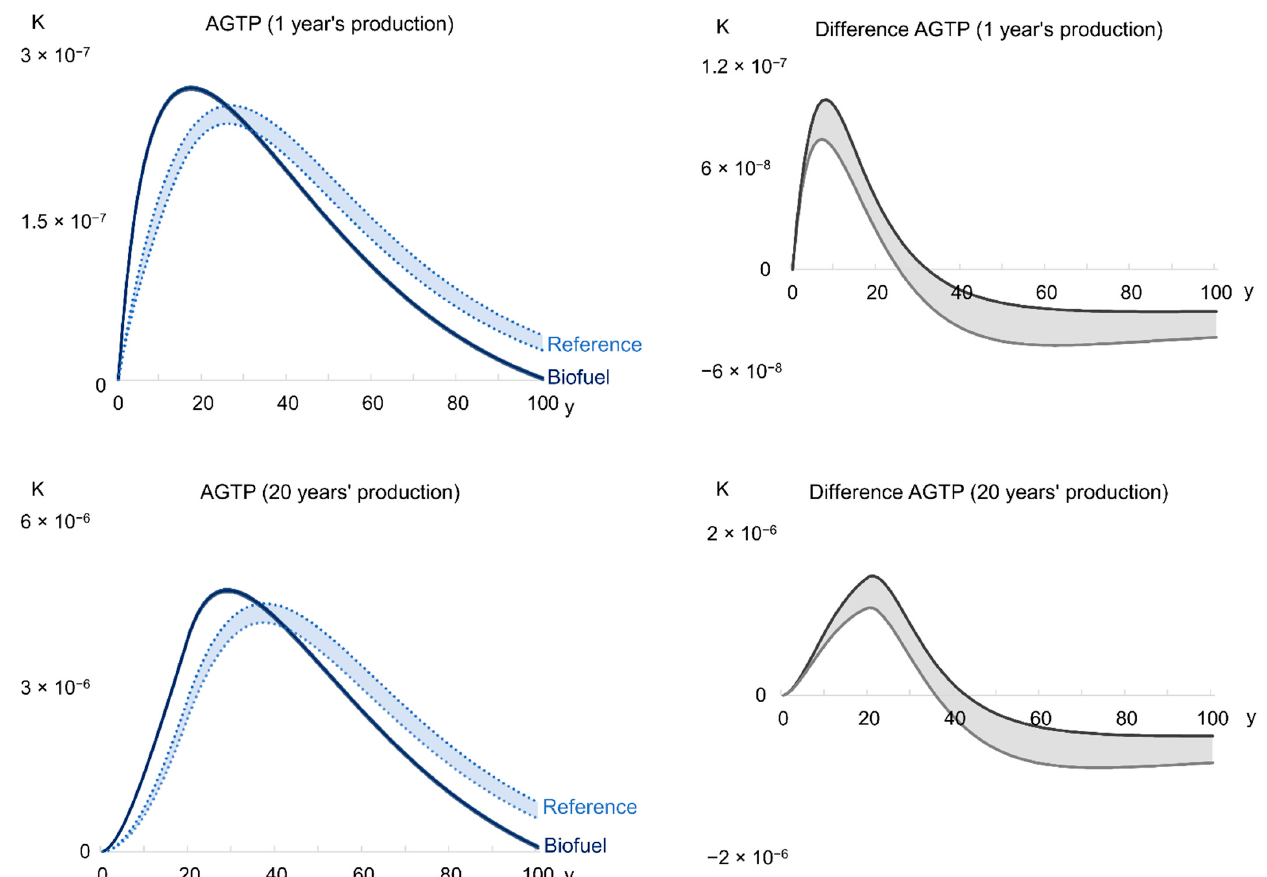
Figure 4. Climate impact in terms of AGTP resulting from handling of logging residues in the biofuel scenario and the reference scenario. The graphs showing climate impact of one year’s production correspond to utilization of 200,000 t DM logging residues, and the graphs showing 20 years of production correspond to utilization of 200,000 t DM logging residues each year for 20 consecutive years. On the right-hand side, the shaded regions show the difference in results for the biofuel and the reference scenario. The upper line shows the climate impact of the high-emission case of the biofuel scenario, with the impact of the low-emission case of the reference scenario subtracted. The lower line shows the climate impact of the low-emission case of the biofuel scenario, with the impact of the high-emission case of the reference scenario subtracted.